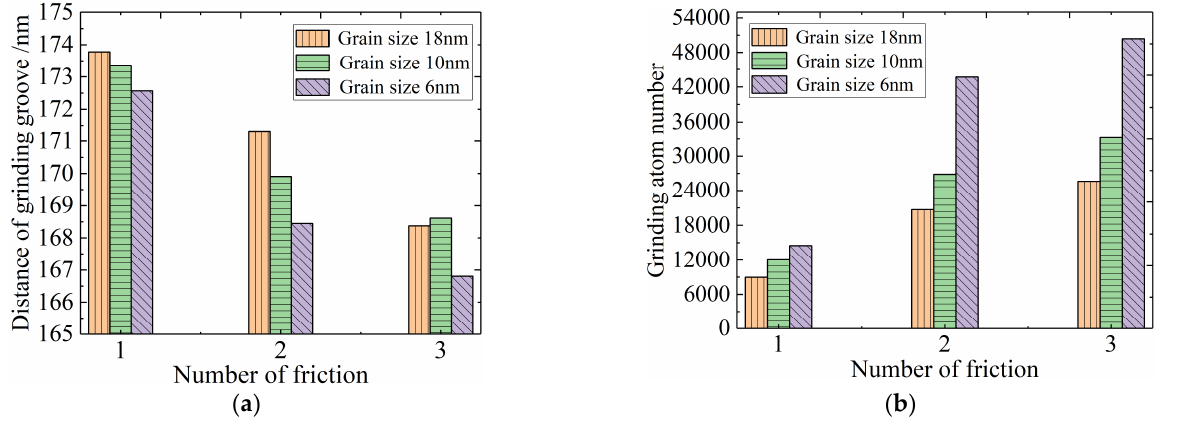
Figure 15. Friction of different grain size of the workpiece: ( a ) is the depth diagram of grinding groove after three frictions at different grain sizes, and ( b ) is the atomic number diagram of abrasive debris discharged at different grain sizes.